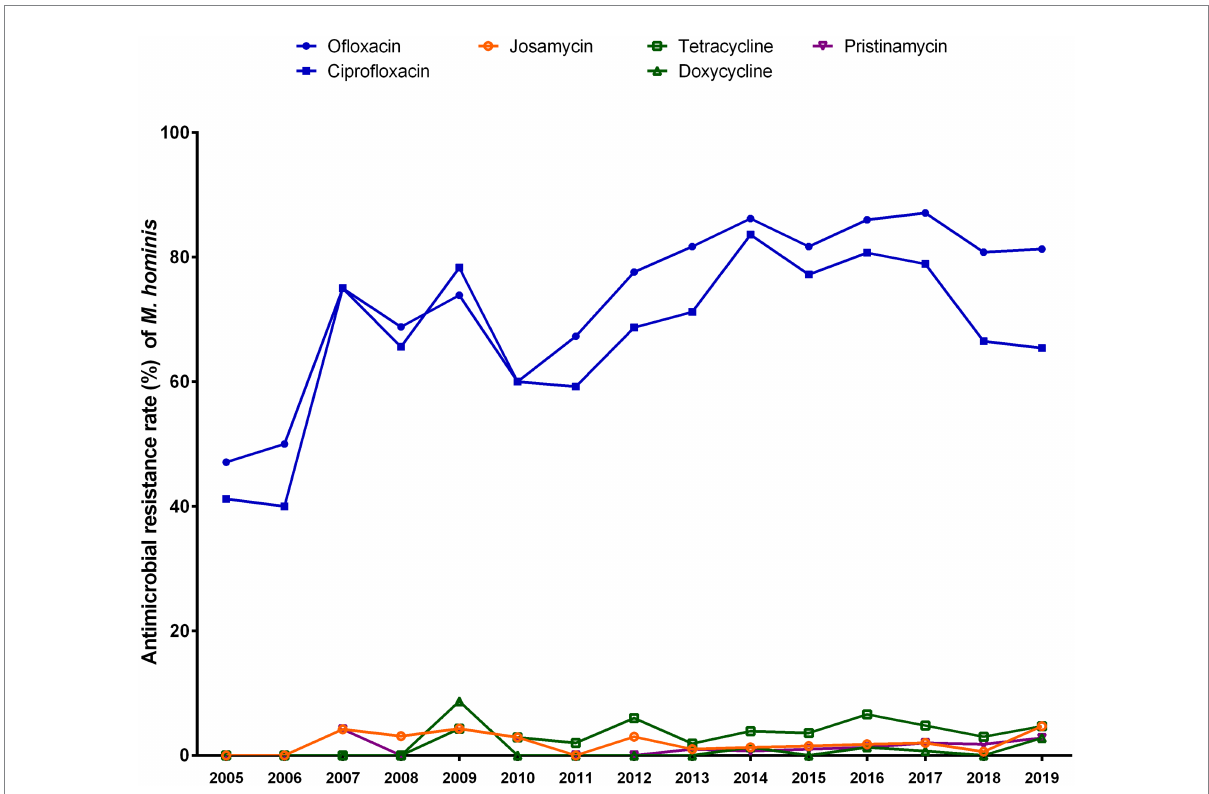
FIGURE 3 Trends in the antibiotic resistance rates of Mycoplasma hominis to six antibiotics from 2005 to